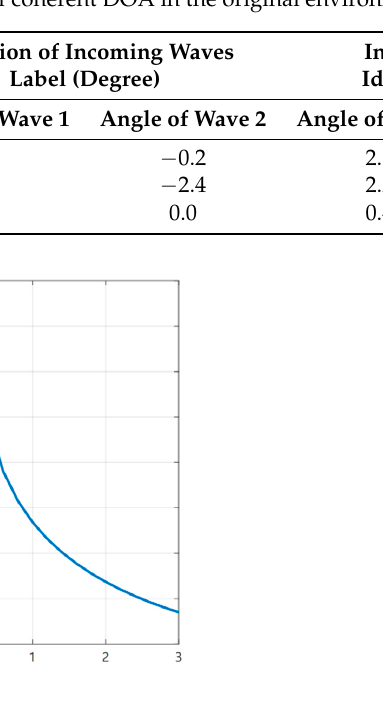
Figure 10. Detection results of Coherent DOA Classical Dimension Reduction Method.